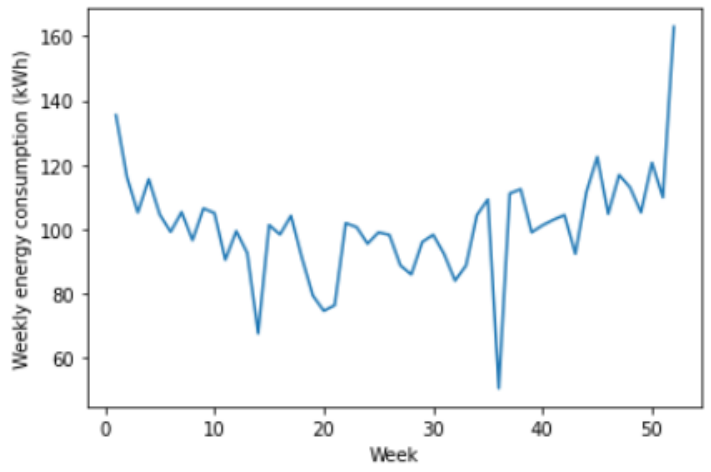
Figure 7. Average weekly energy consumption by year.